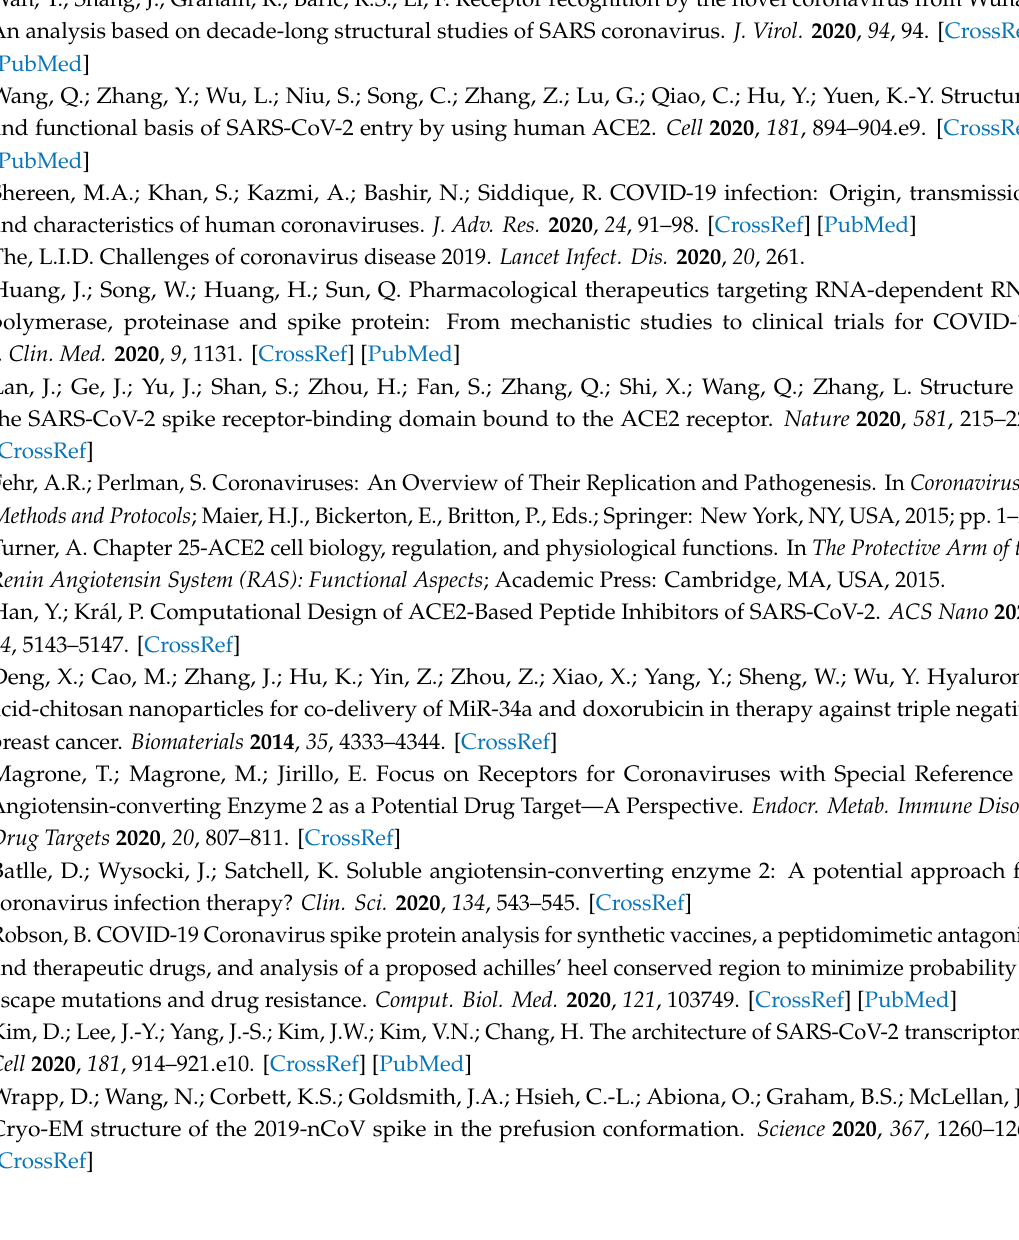
Figure S1. Structural alignment of TR2 for both SARS-CoV (green) and SARS-CoV-2 (red); the annotated amino acids represent those that di ff er between the two viruses; Figure S2. The main contacting residues from ACE2 with RBM